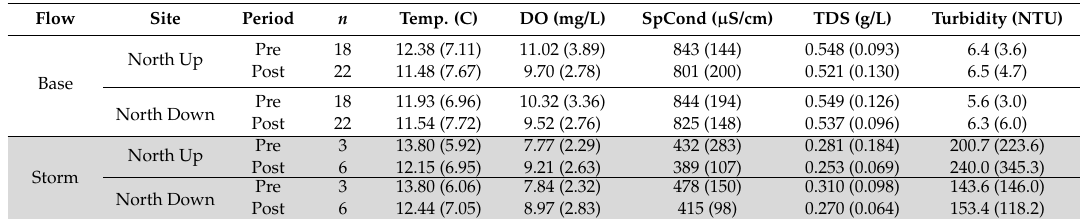
Table 9. Grand mean (1 SD) values of water quality parameters at the Haworth wetland restoration site in pre- and postrestoration sampling periods. Values in the top half of each cell represent prerestoration (Apr. 2014–Sep. 2015); values in the bottom half represent postrestoration (Oct. 2015–Nov. 2017). Storm flow data shown in gray shade.